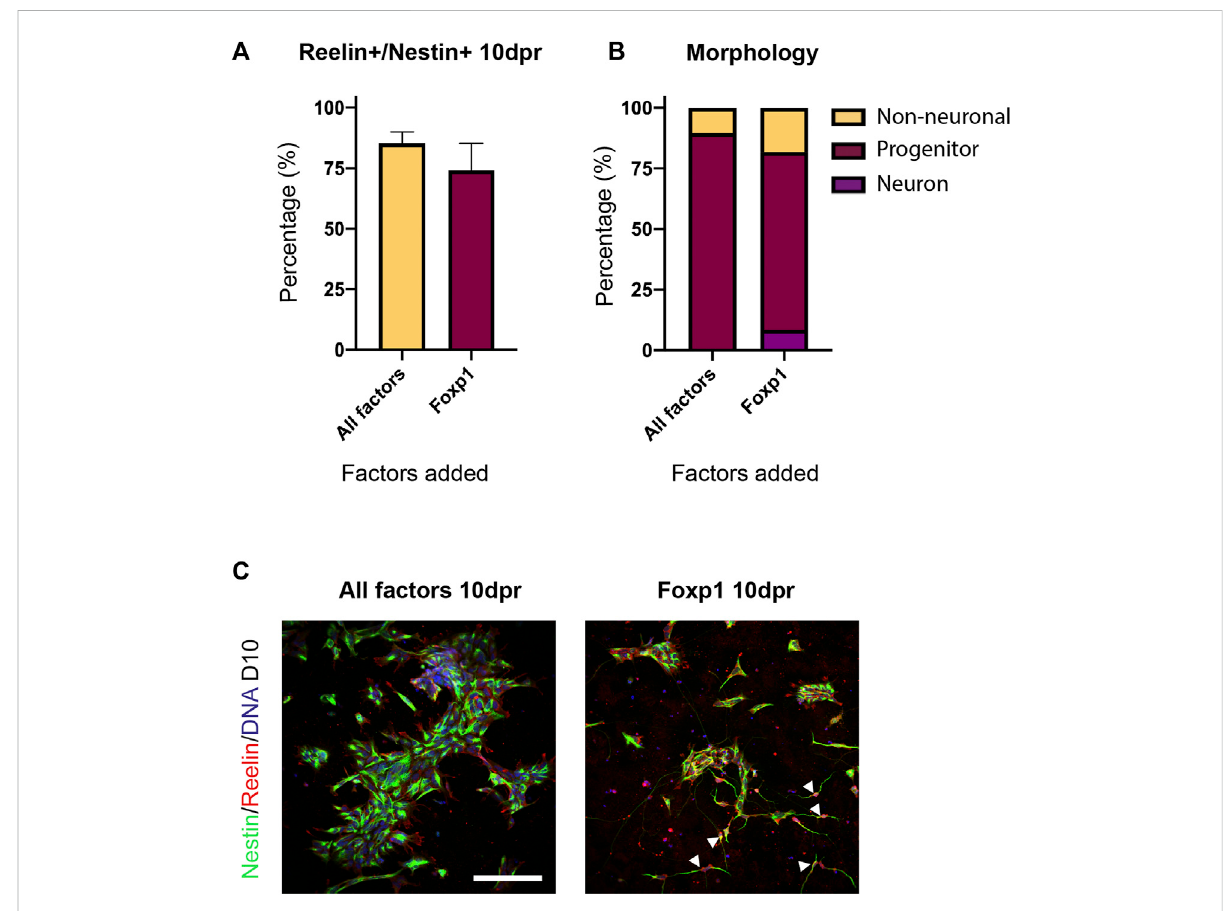
FIGURE 7 Ef fi ciency and morphology of transduced induced pluripotent stem cells (iPSCS) containing all factors or containing Foxp1 alone. (A) Co- expression of Reelin and Nestin in cells 10 days post induction (dpi) was not signi fi cantly different between the All-factors treatment or with Foxp1aloneintheSFC180humaniPSCline.ExperimentalN=3 (B) MorphologyoftransducedcellsrevealedahighconversionintoNestinexpressing progenitors and neurons in the SFC180 iPSC line and the presence of more neurons when Foxp1 was used alone. (C) Immunostaining showing Nestin and Reelin expression in cells 10 dpi in the All-factors combination and Foxp1 alone. White arrowheads highlight neuron morphology. Scale bar: 150 μ